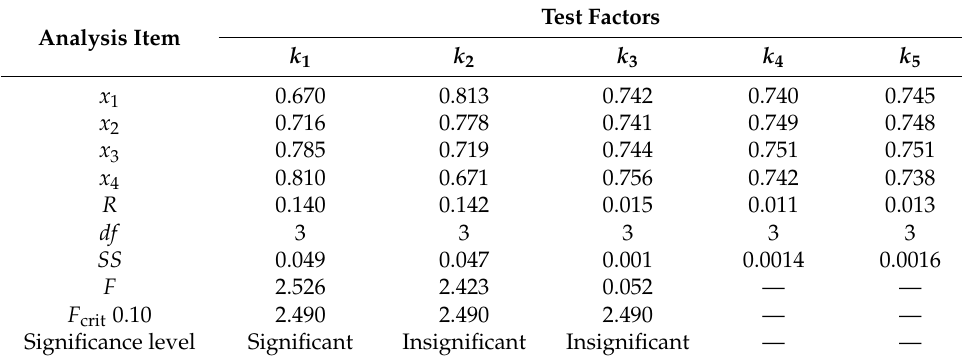
Table 4. Range and variance analysis of factors in a dry road state.